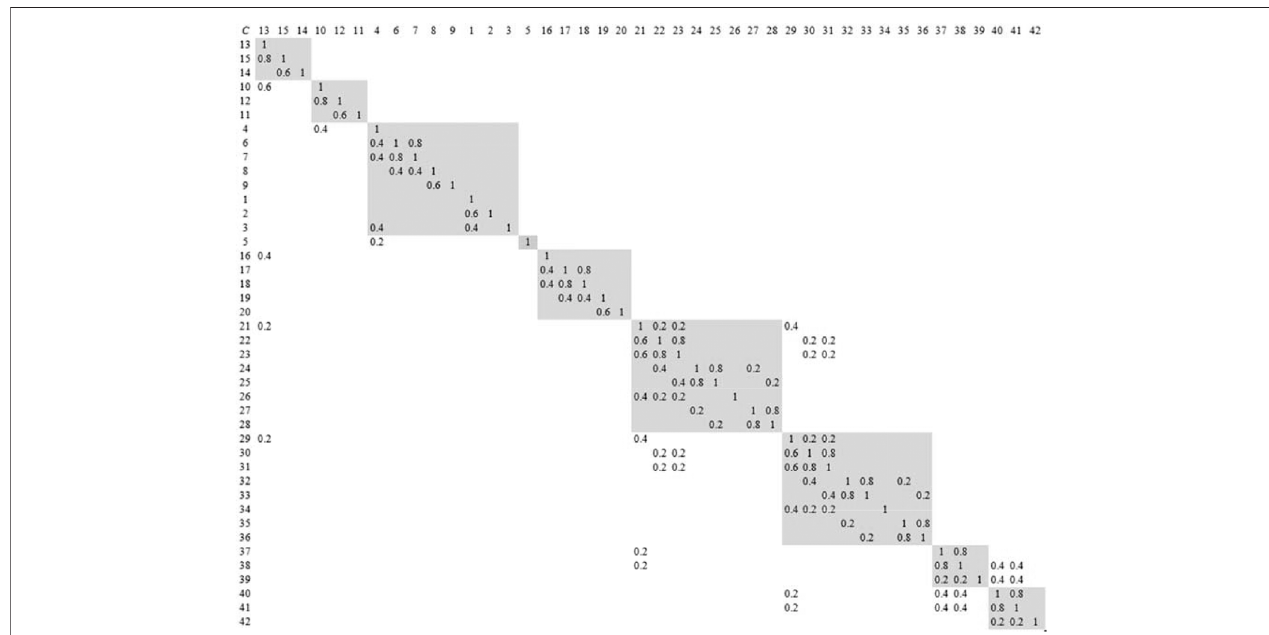
FIGURE 8 | DDM of the grab with